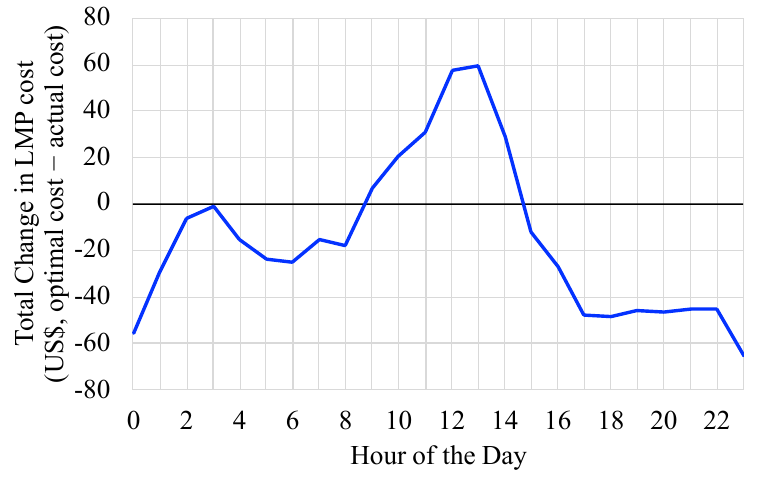
Figure 7. Hourly variation in total change in the LMP